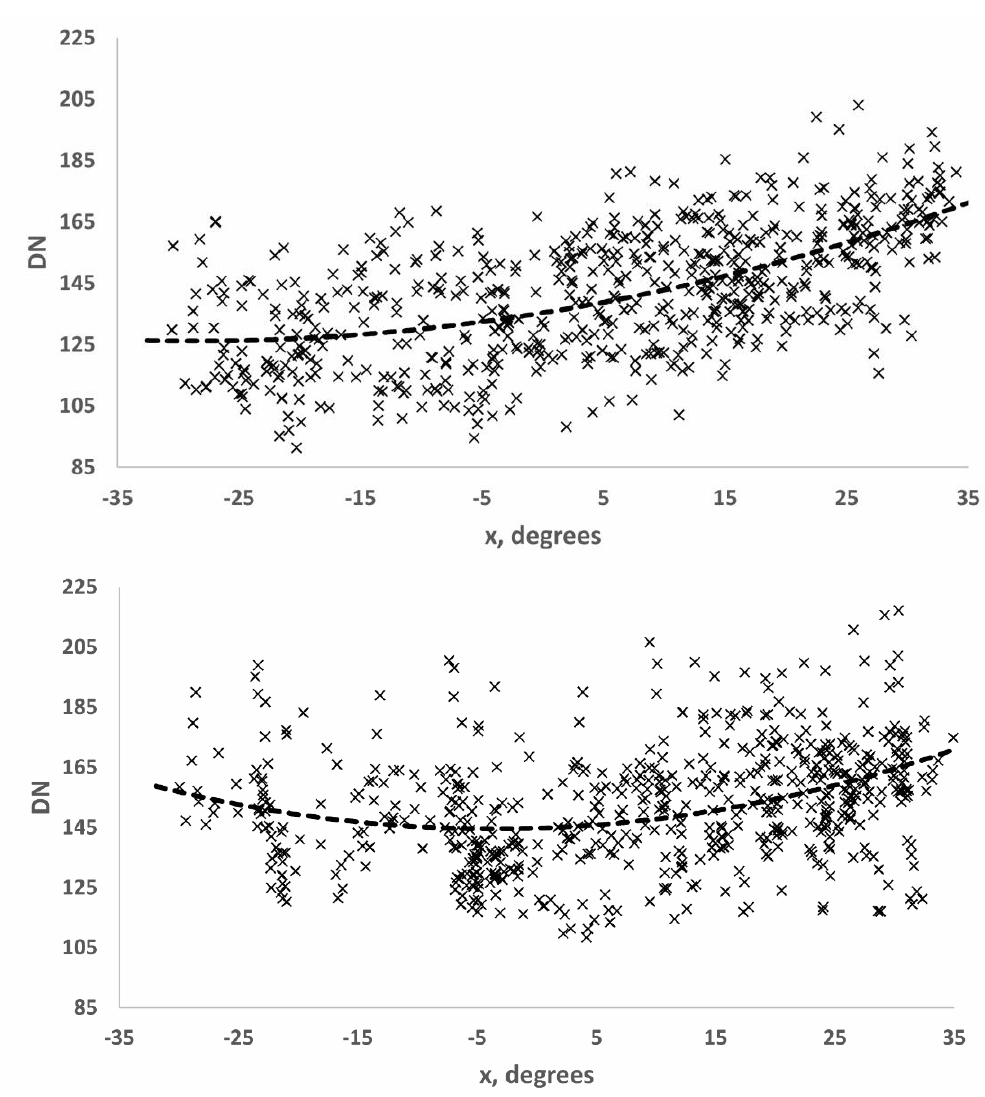
Figure 8. GRN band mean feature as a function of x in Equation 1 . HO (upper pane) shows an increase also in the forward scattering geometry ( x < 0  ), while HHU (lower pane) shows a